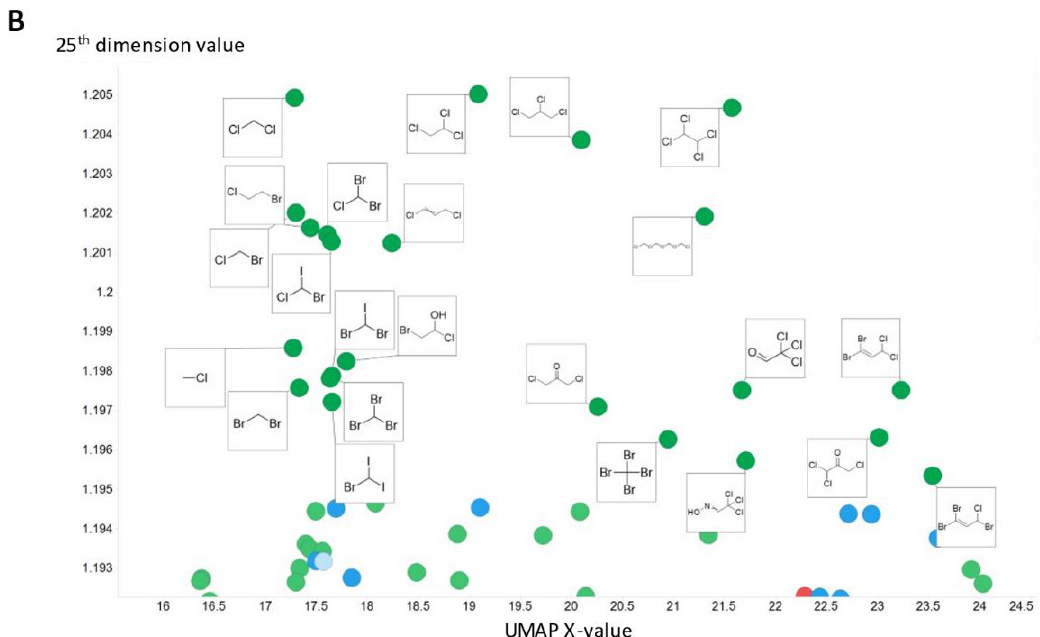
Figure 8. Effective disentanglement of molecular features into individual dimensions, using the indicated values of 25th dimension of the latent space of the 2nd dataset. In this case we used a latent space of 256 dimensions and a temperature t of 0.05. ( A ) Trihydroxycyclohexane derivatives, ( B ) halide-containing moieties. encoding (https://www.rdkit.org/docs/source/rdkit.Chem.rdmolops.html, accessed on 28 February 2021).